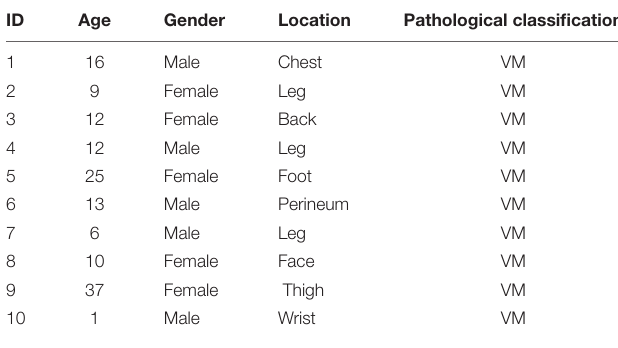
TABLE 1 | Clinical characteristics of